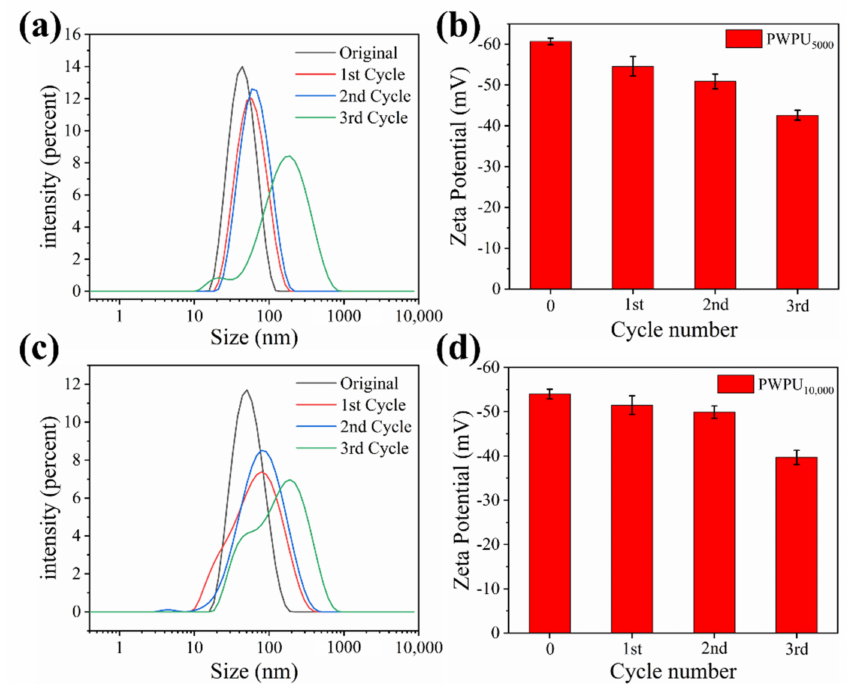
Figure 11. ( a ) Particle size and distribution of recycled PWPU 5000 emulsions; ( b ) zeta potential of recycled PWPU 5000 emulsions; ( c ) Particle size and distribution of recycled PWPU 10,000 emulsions; ( d ) zeta potential of recycled PWPU 10,000